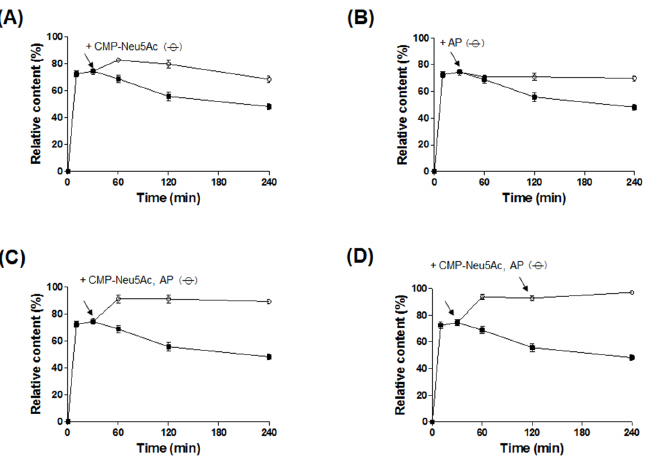
Fig 6. Optimized P145-ST reaction for increase of S2 glycan generation. For increase of S2 glycan content (%), additional CMP-NeuAc (A) or AP (B) was added 30 min after the beginning of the P145-ST reaction. Further increase of S2 glycan content was achieved by the simultaneous addition of CMP-NeuAc and AP at 30 min of the reaction (C). Through two sequential additions of both CMP-NeuAc and AP at 30 and 120 min of the reaction, relative content of S2 glycan increased up to 98% (D). Arrows indicate the time points for additions of CMP-NeuAc and/or AP. Open circles and filled squares represent the relative contents (%) of S2 glycan generated by the reactions with and without the supplemental addition